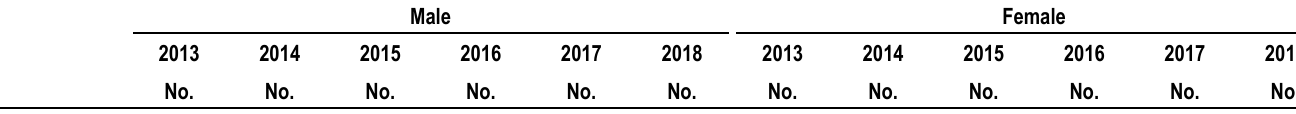
Table 8b. Diagnoses of HIV infection attributed to injection drug use, by selected characteristics, 2013–2018—United States and 6 dependent areas